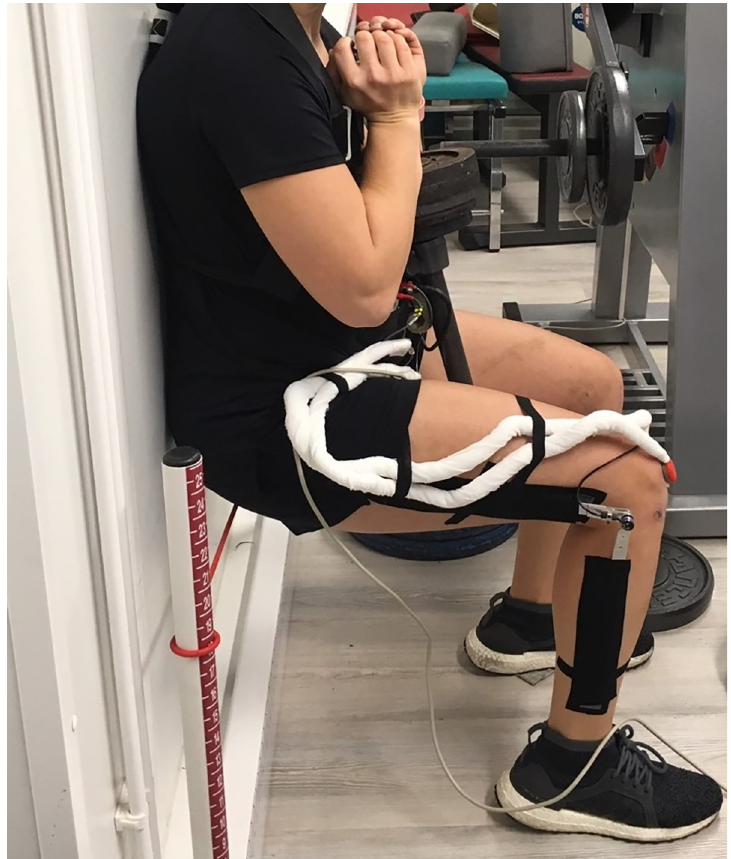
Fig 2. Sitting position using the tactile stimulus from a tensioned rope during the modified sit-to-stand movement and with an additional weight equal to 20% of the participant’s body weight.